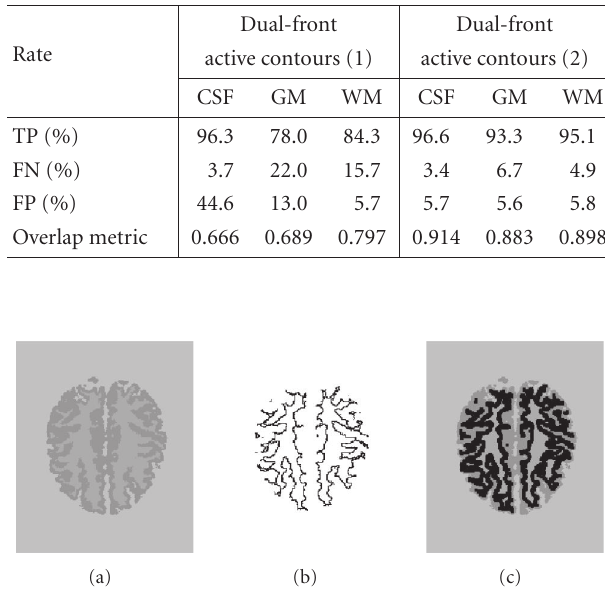
Figure 5: Morphological dilation a ff ects the topology structure of evolving fronts and also a ff ects the accuracy of segmentation results. (a) The formed partition diagram on one slice after a number of it- erations and di ff erent regions with di ff erent gray values represent di ff erent tissues; (b) the extracted boundary between GM and WM tissues on the same slice as that shown in (a); (c) the formed ac- tive region (the most black region) by dilating the boundary shown in